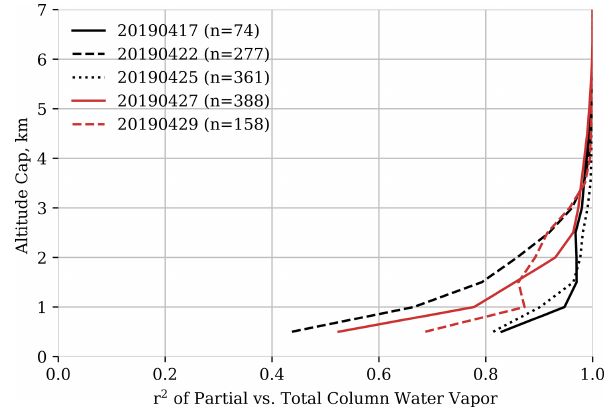
Figure 12. Data from HALO flights suggest that the PBL domi- nates the total column variability. Correlation coefficients between the lowest atmospheric layer and the total column water vapor for different capping